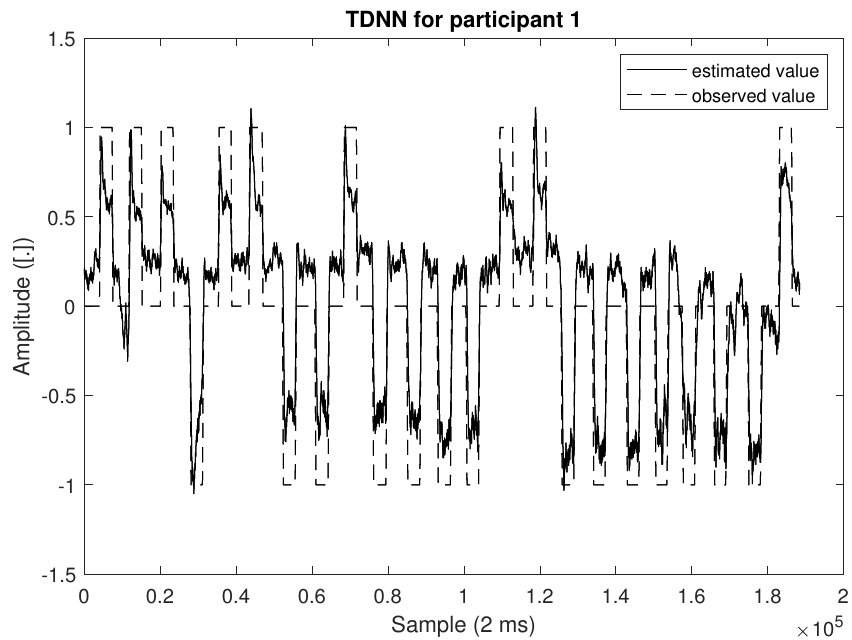
Figure 6. Comparison between the observed value and estimated value in the